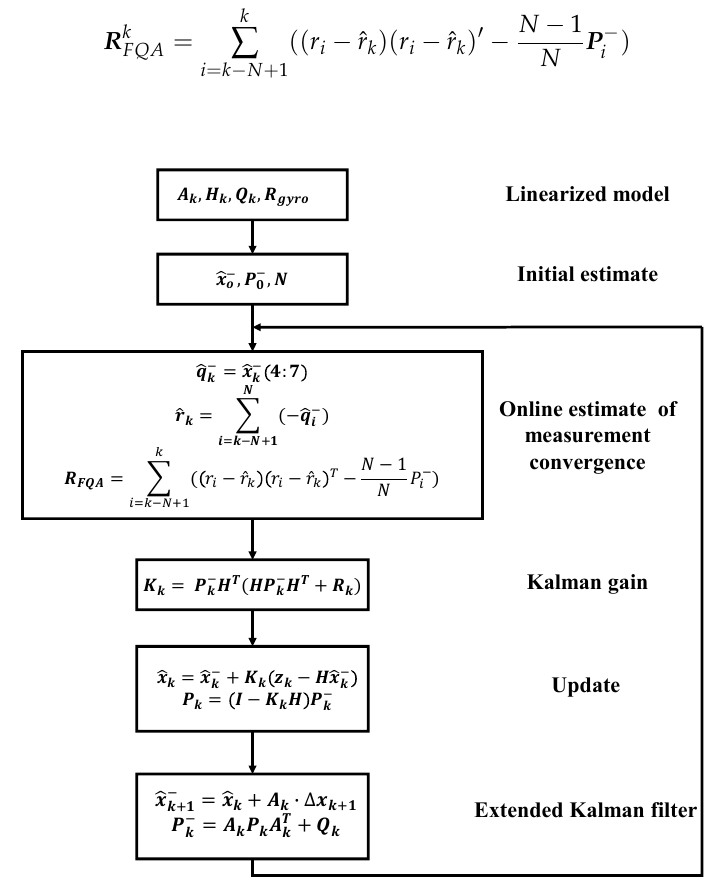
Figure 3. Block diagram of the adaptive Kalman